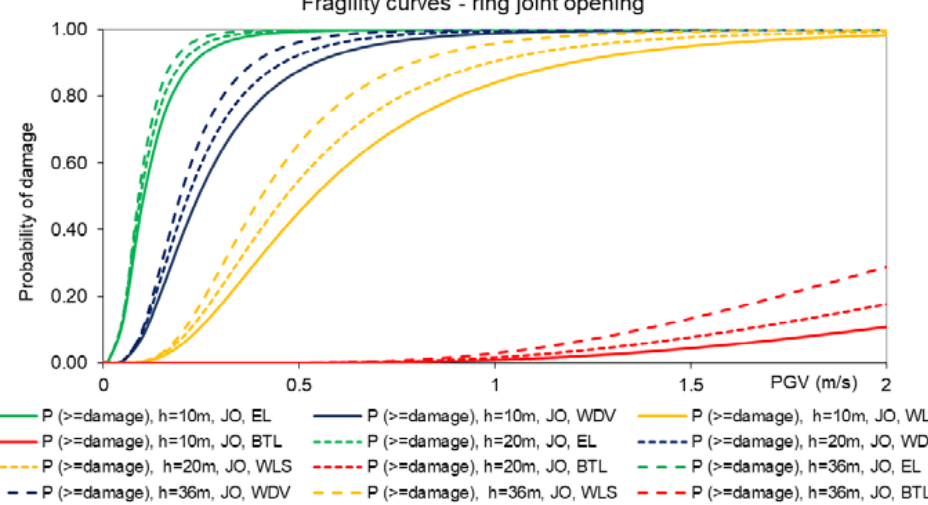
Figure 12. Analytical fragility curves developed by Dong et al. [95] for segmental circular tunnels, subjected to ground seismic shaking in the longitudinal direction, for various damage states (JO: Joint Opening; EL: Elastic Limit of bolts (PL1); WDV: Waterproofness Design Value (PL2); WLS: Waterproofness Limit State (PL3); BTL: Tensile Limit of bolts (PL4)), assuming various burial depths, h .